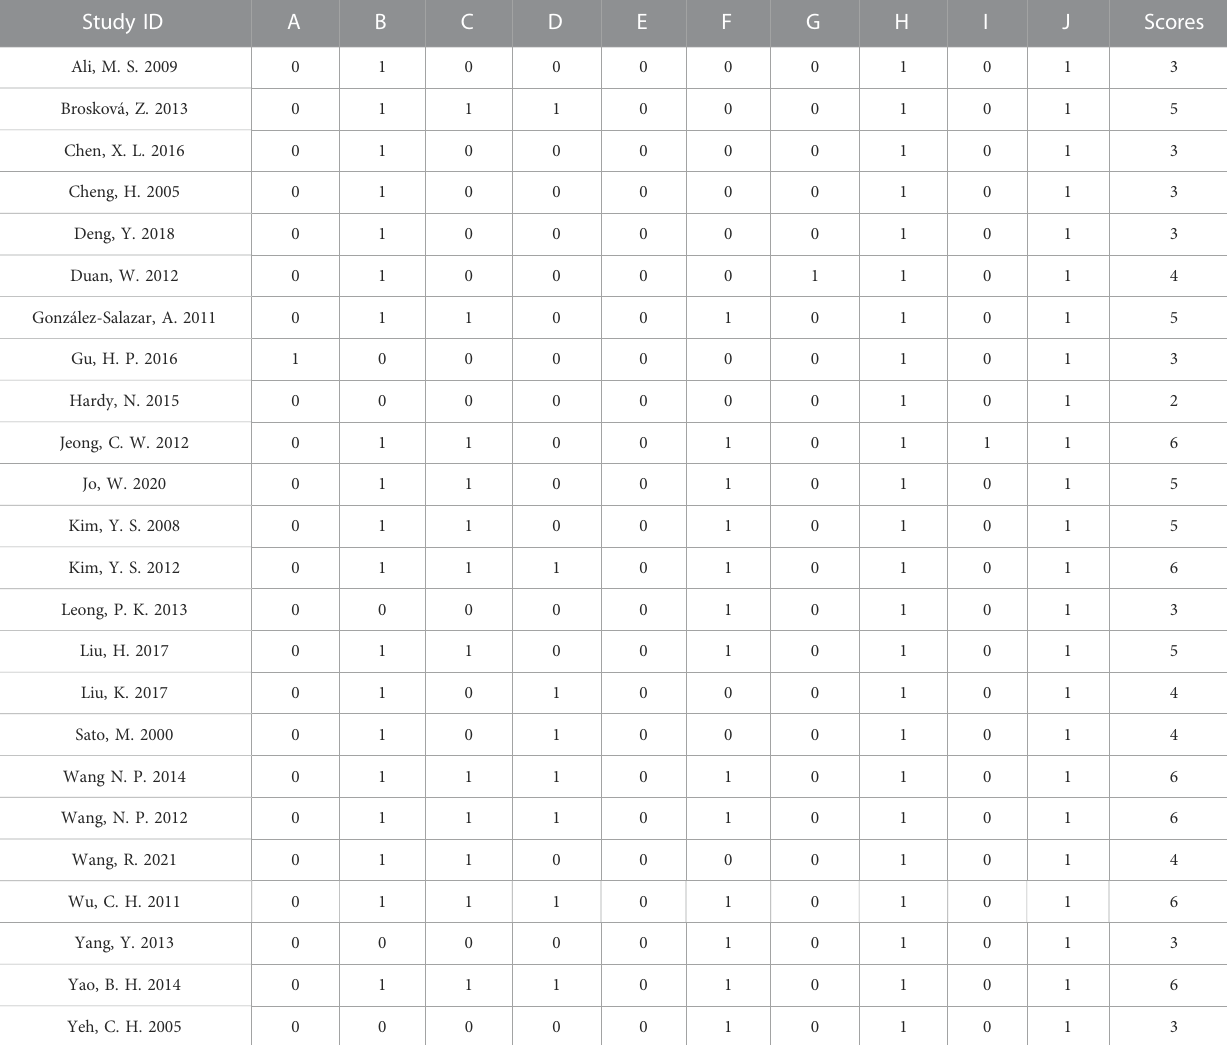
TABLE 3 Methodological quality of included animal studies (SYRCLE tool).